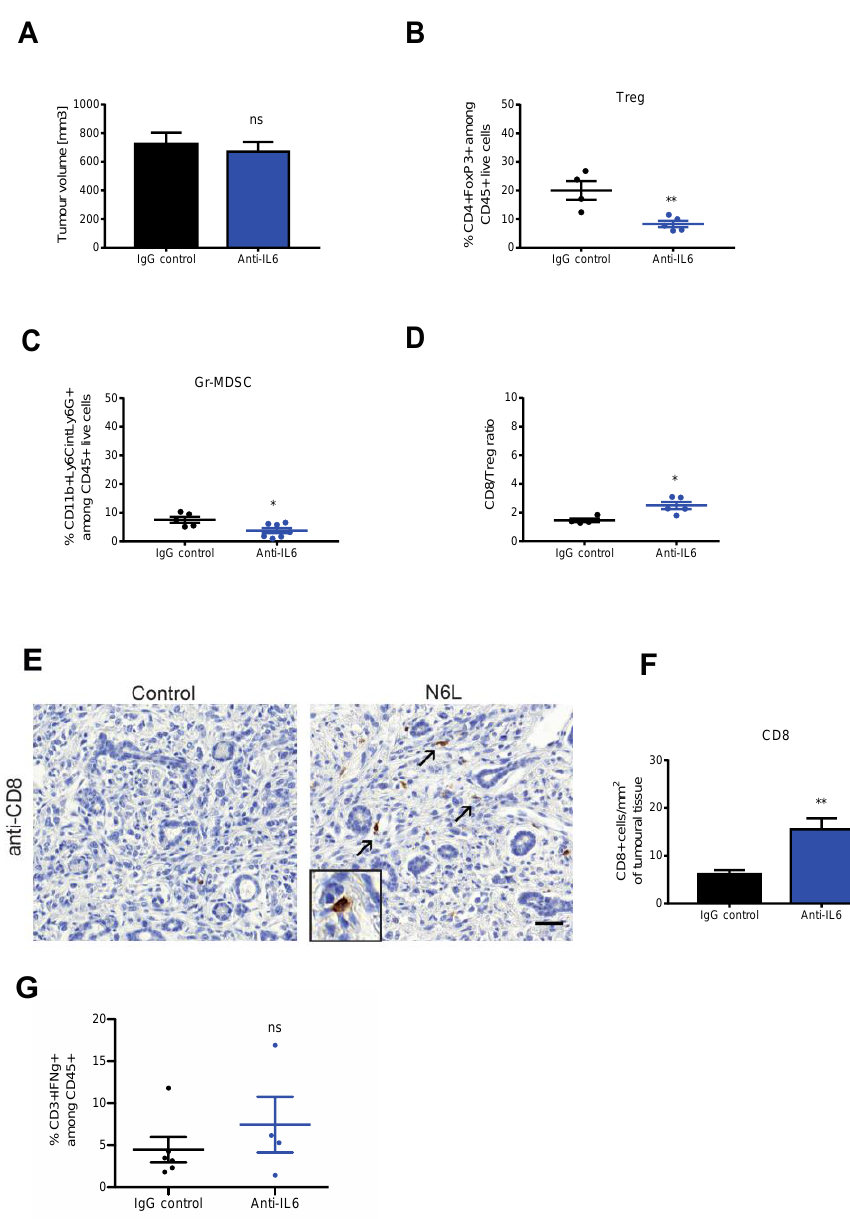
Figure 6. Anti-IL-6 antibody mimics N6L effects on PDAC immune microenvironment. mPDAC tumours were generated as in Figure 2 and treated with anti-IL-6 blocking antibody or IgG control antibody for three weeks, three times per week, by i.p. injection. Mice were sacrificed 21 days after the treatments. ( A ) Tumour volumes were measured as in Figure 2, and graphs show a representative experiment (from two independent experiments). ( B – D ) Immune cell populations in tumour tissues were analysed by flow cytometry as in Figure 2. Tregs and PMN-MDSC were analysed, and the results are plotted as the fold change of the % of ( B ) CD45 + CD4 + FoxP3 + cells and ( C ) CD11b + Ly6G + Ly6C low cells in N6L-treated tumours relative to control tumours. ( D ) Fold change of the CD8/Treg ratio between control and N6L-treated tumours. ( E ) Tumour sections of control and anti-IL-6-treated mice were immunostained by an anti-CD8 antibody, CD8 + cells were counted (arrows), and results were plotted as ( F ) the number of cells/mm 2 . Scale bar: 50 μm. p -values were calculated between indicated conditions by two-tailed Mann-Whitney t -test (**, p < 0.01; *, p < 0.05; n = 5 mice). ( G ) Effector T cell activation was analysed by flow cytometry as in Figure 3C, and the % of CD3 + IFN γ + cells in control and N6L-treated mice is plotted (two-tailed Mann-Whitney U-test **, p < 0.01; control, n= 5 mice; anti-IL-6, n = 4 mice).